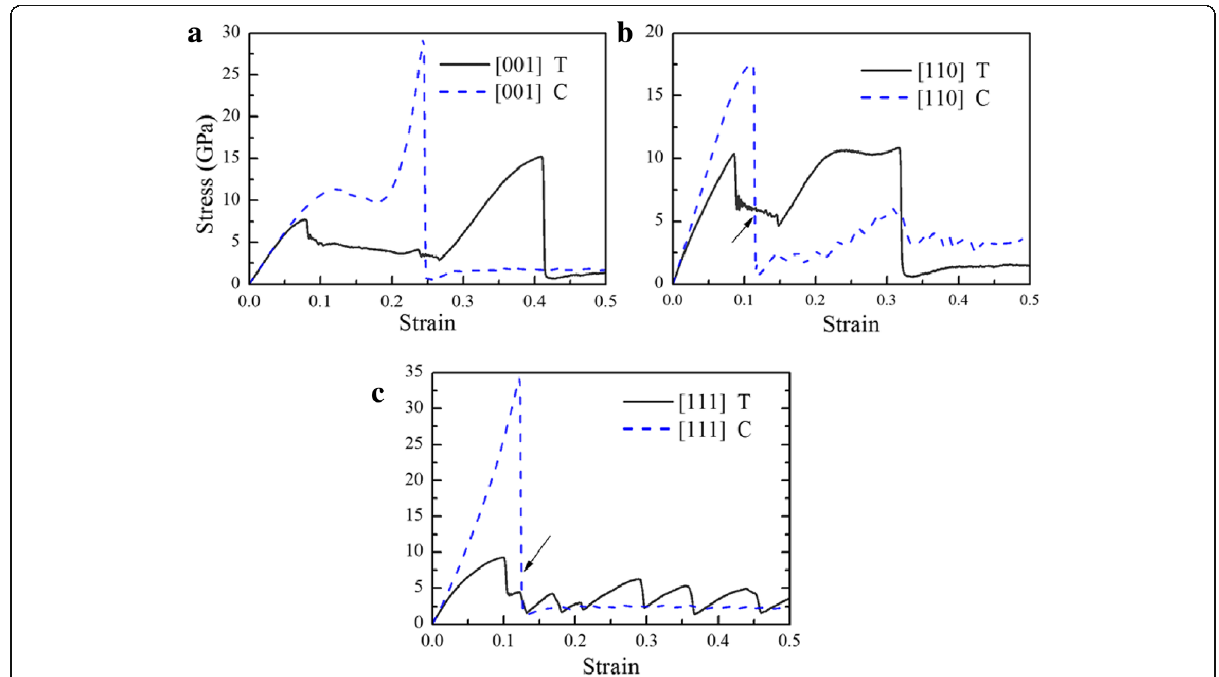
Fig. 2 σ - ε curves of samples under tension (T) and compression (C). a [001], b [110] and c